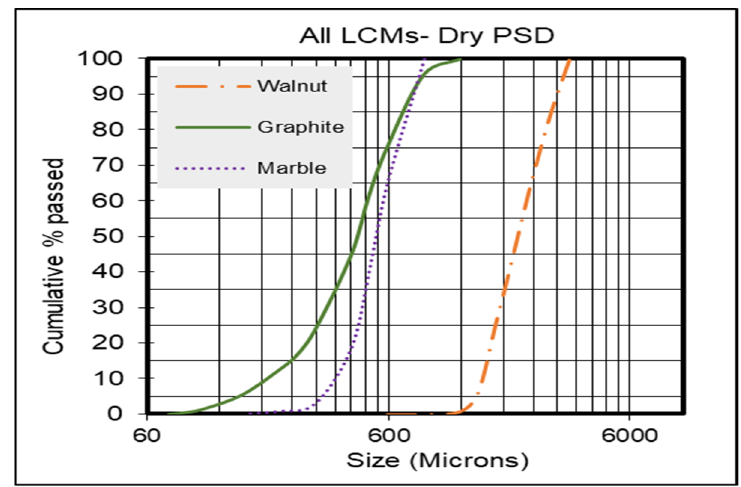
Figure 1. Dry PSD for walnut, graphite, and marble.